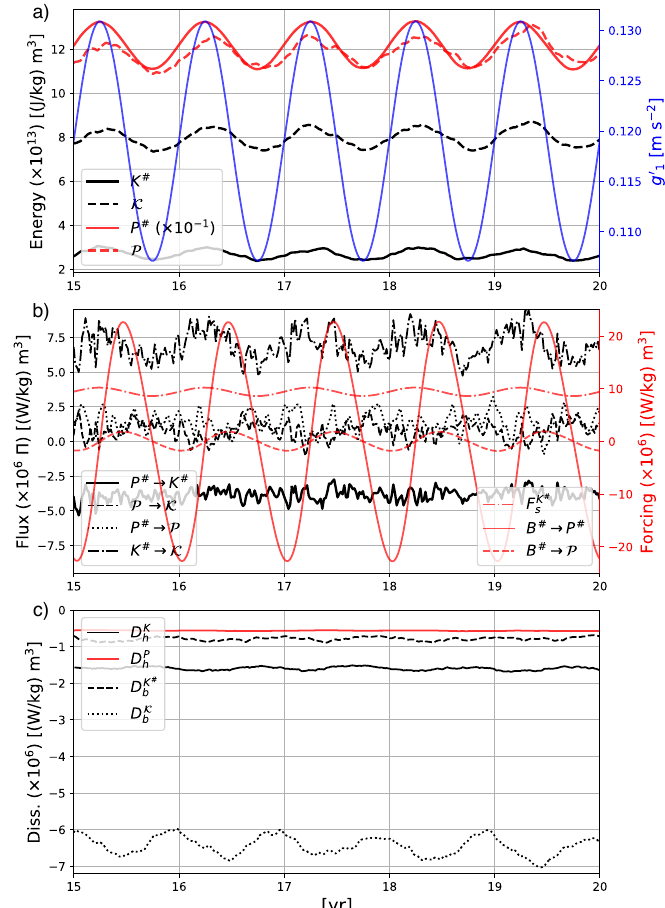
Figure 4. Time series of each term in the domain-integrated LEC. ( a ) The mean and eddy KE (black) and APE (red) reservoirs in the units of × 10 13 [(J/kg) m 3 ] and stratification of the first layer interface (blue; g (cid:48) ). MAPE is multiplied by 0.1 to have it fit on the same y axis. ( b ) The energy fluxes between 1 each energy reservoir and forcing terms due to surface wind stress ( F K # s ) and temporally varying BPE. ( c ) Dissipation terms due to horizontal viscosity ( D h ) and bottom friction ( D b ). The mean and eddy horizontal dissipation terms are lumped together and fluxes are in the units of × 10 6 [(W/kg) m 3 ]. The forcing and dissipation terms are detailed in Appendix